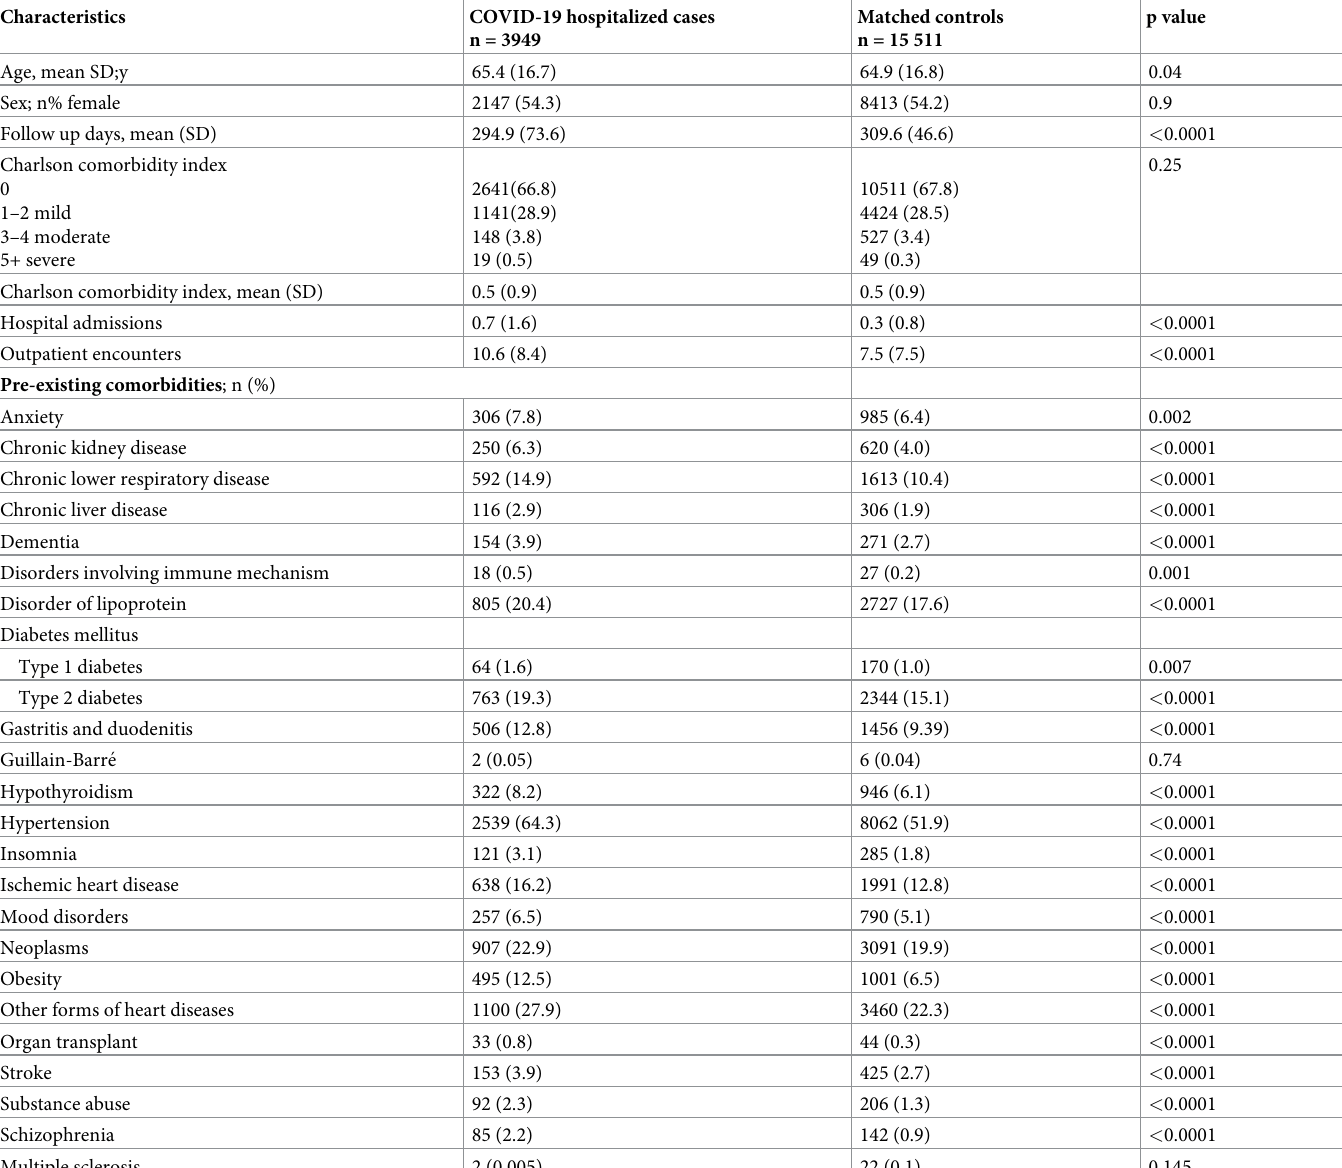
Table 1. Baseline descriptive characteristics of patients who were hospitalized with COVID-19 and matched general population controls during 2020–2021 in Estonia.